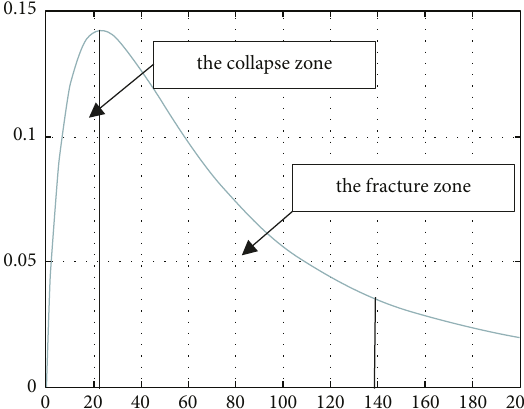
Figure 10: Analysis of “three zones” height in overlying strata. (The abscissa is the height, and the ordinate is the shear